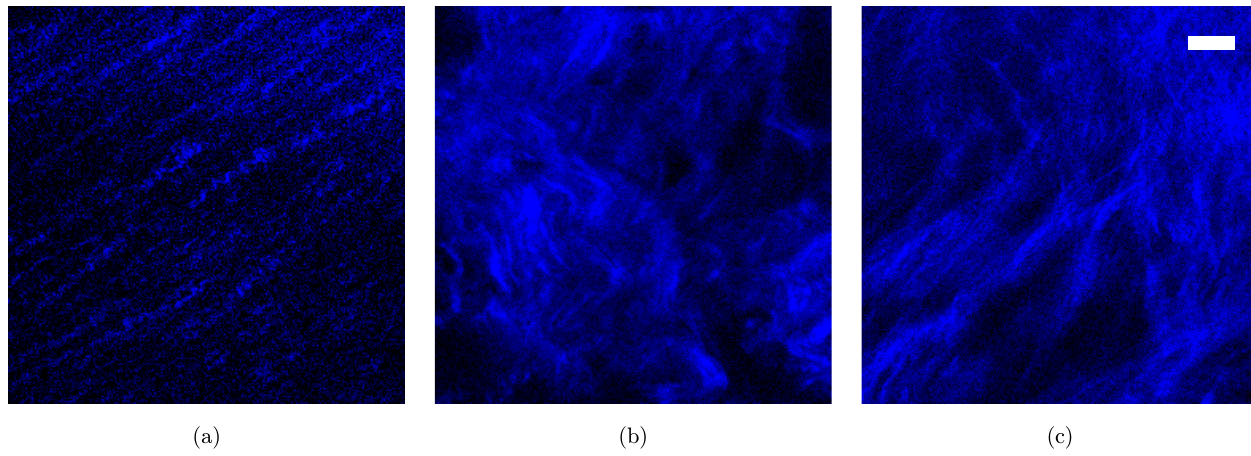
Fig. 6. Ex vivo SHG imaging of collagen in (a) intima, (b) adventitia and (c) plaque. (Bar: 20 (cid:4)